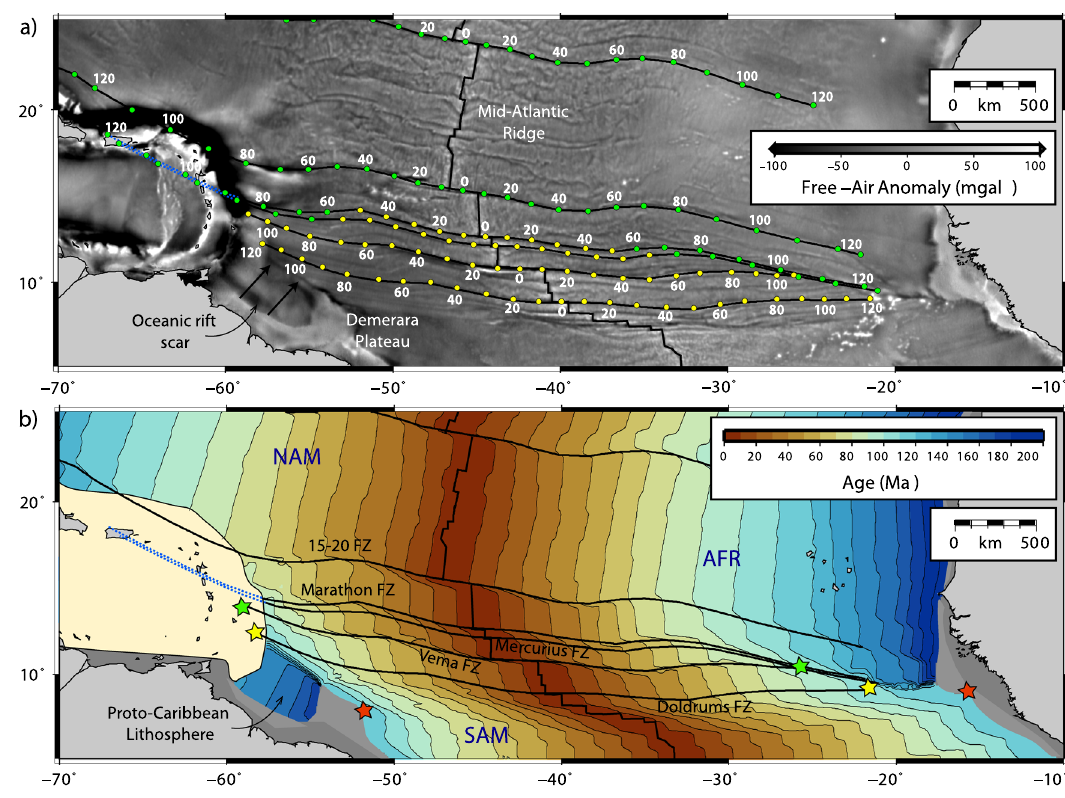
Fig. 10 Present-day age structure of the Central Atlantic predicted by the plate reconstruction by Müller et al. 26 with our plate boundary adjustments. a Satellite-derived free air-gravity anomaly, with observed fracture zone traces (thick black lines). Coloured dots (ages in Ma) are from the plate reconstruction predictions, with green dots representing segments produced by Central/ Equatorial – Atlantic spreading (NAM – AFR poles), and yellow dots those produced by Equatorial – Atlantic spreading (SAM – AFR poles). See Supplementary Fig. 10 for details. A northward propagation of NAM – SAM – AFR triple junction is shown by the transfer along Mercurius and Marathon FZs from NAM to SAM poles. In other words, the NAM – SAM boundary has not been stable over time, especially for the older parts of the oceanic lithosphere relevant for our study. b Predicted sea fl oor age structure. Colour scale from ref. 68 . Green, yellow and red stars indicate matching points along the conjugate margins. Note the small fragment of relatively old Proto-Caribbean lithosphere entering the southern Lesser Antilles. Dotted blue line illustrates the trace of the subducted Marathon and Mercurius fracture zones, which are interpreted to form the boundary between the Equatorial and Central Atlantic